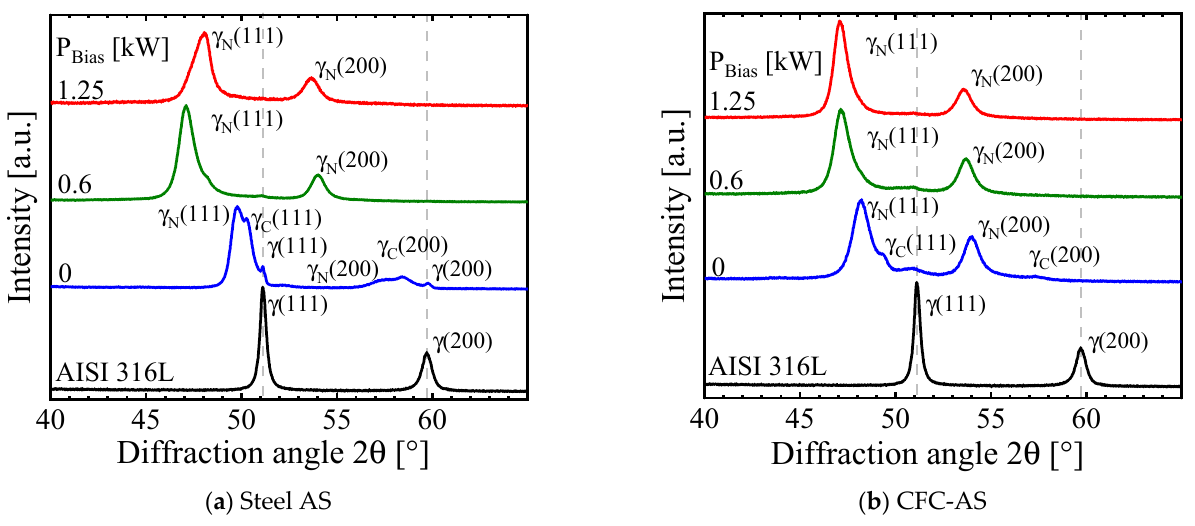
Figure 13. X-ray diffraction pattern measured at the surface of ASPNC samples treated at different bias conditions for a steel AS ( Φ CH4 = 4 slh) ( a ) and a CFC-AS ( b ) at H 2 :N 2 = 1:1, p = 3 mbar, T = 460 °C, Φ Total = 80 slh, and t = 5 h.